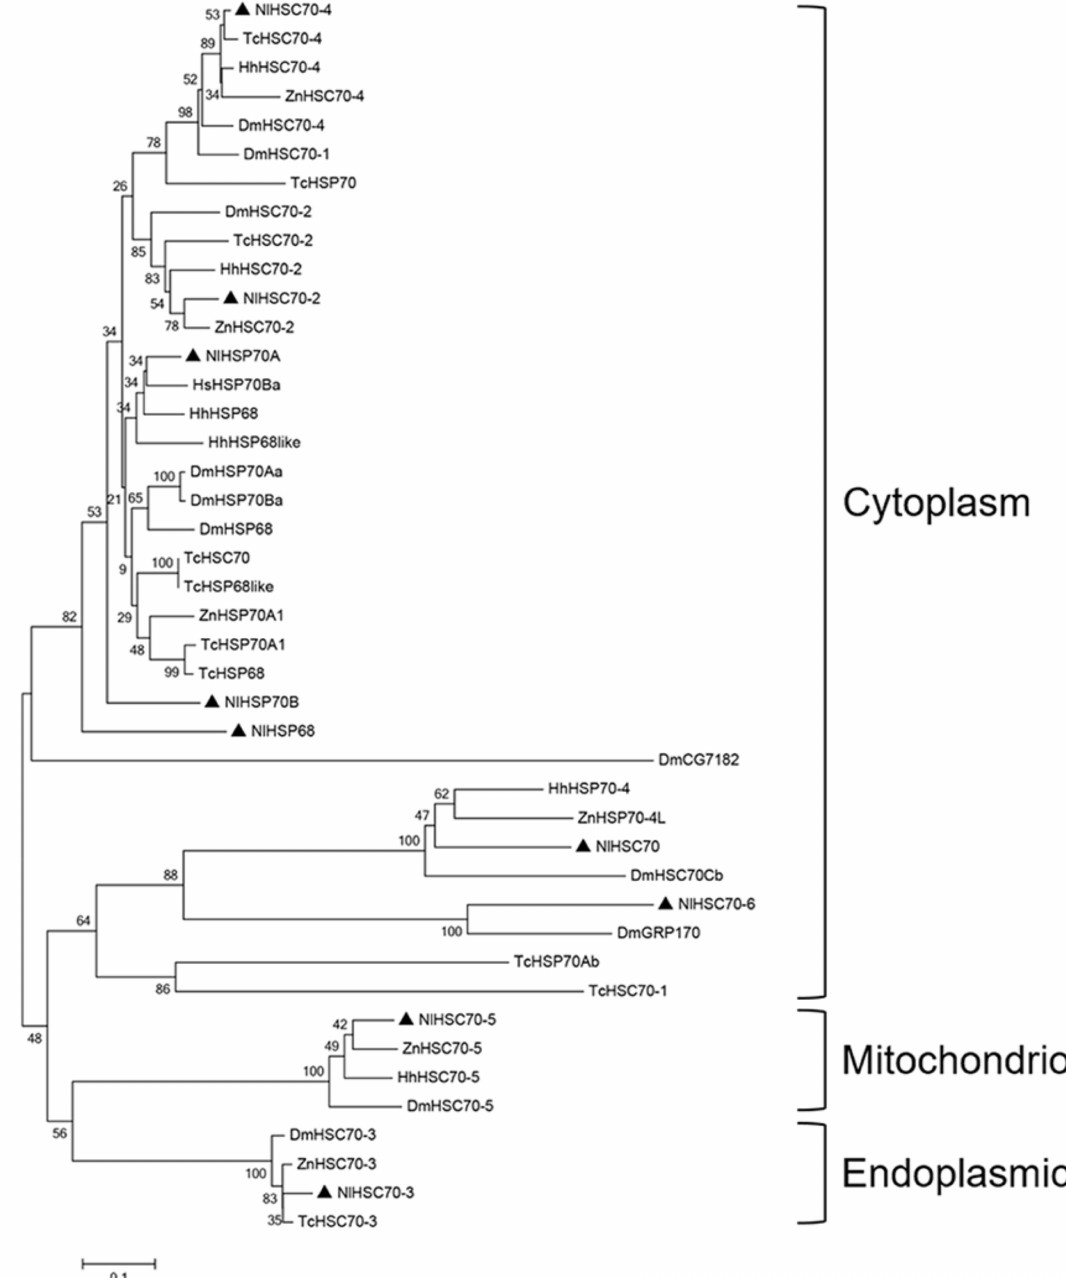
Figure 2. Phylogenetic analysis of HSP70 genes in BPH. The phylogenetic tree was constructed based on 47 HSP70 homologs derived from five species (Table S1) by the neighbor-joining method. Bootstraps were set with 1000 replications. NlHSP70 members are shown in black